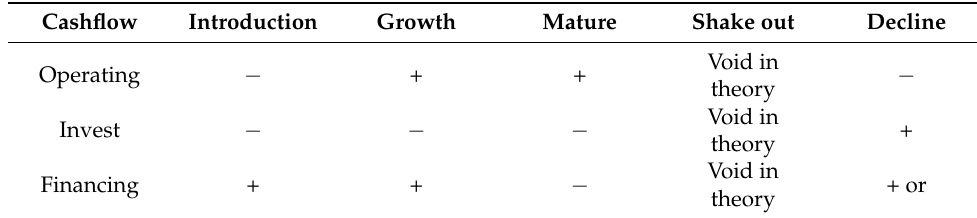
Table 1. Cashflow patterns for each life cycle